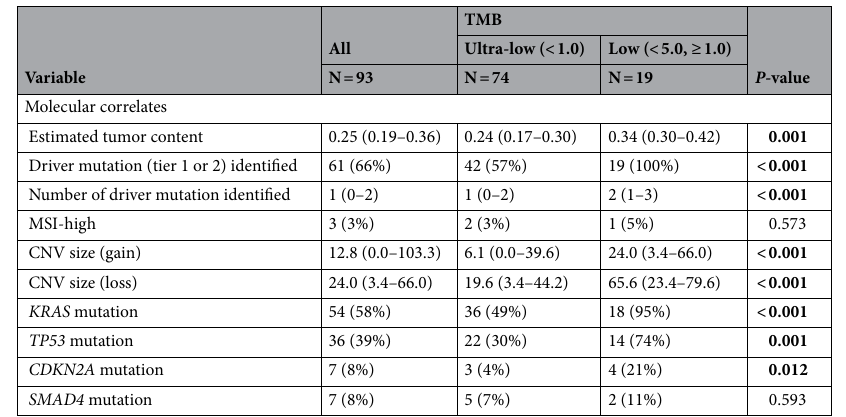
Table 2. Molecular correlates according to the TMB status. TMB tumor mutation burden, MSI microsatellite instability, CNV copy number variants. Significant values are in bold.